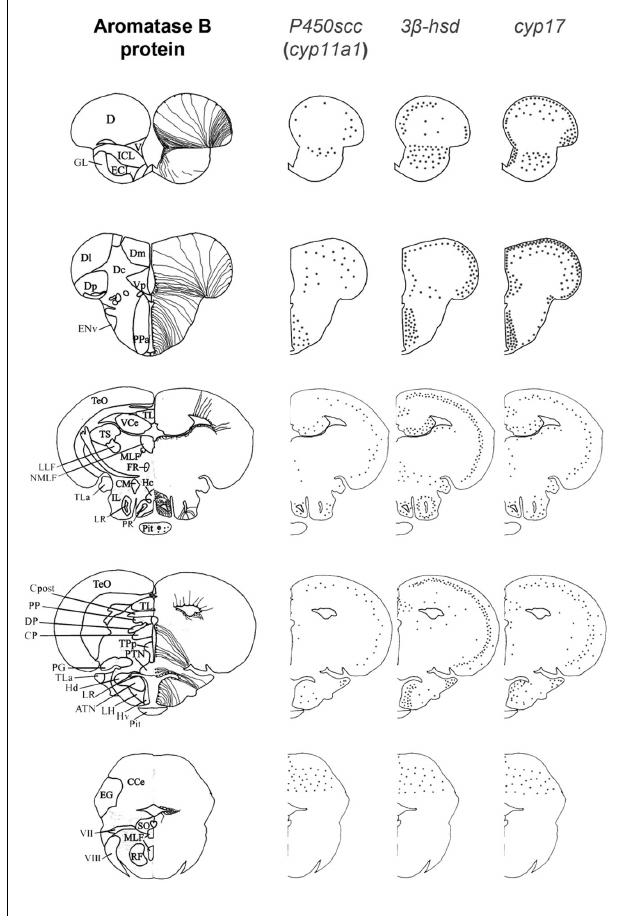
FIGURE 3 | Schematic distribution of cyp11a1, 3 β -hsd, and cyp17 mRNA-expressing cells in representative sections taken from the zebrafish brain atlas (adapted fromWullimann et al., 1996). The cyp11a1 , 3 β -hsd, and cyp17 transcripts represented by black dots, exhibited a roughly similar distribution. Aromatase B-expressing cells are represented in the left panel (according to Menuet et al., 2005) where cell bodies are represented by dots, while thin lines figure radial